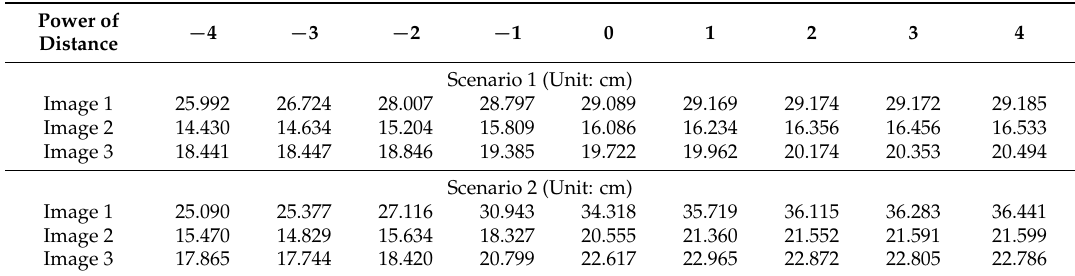
Figure 11. The distribution of control points for analysis of their optimal weights. Table 6. The position error of analysis of adaptive weight for the iPhone 5S.